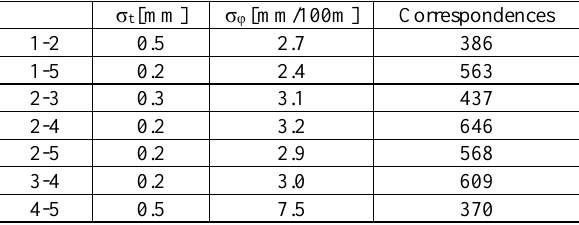
Table 1. Generated results of the plane-based registration